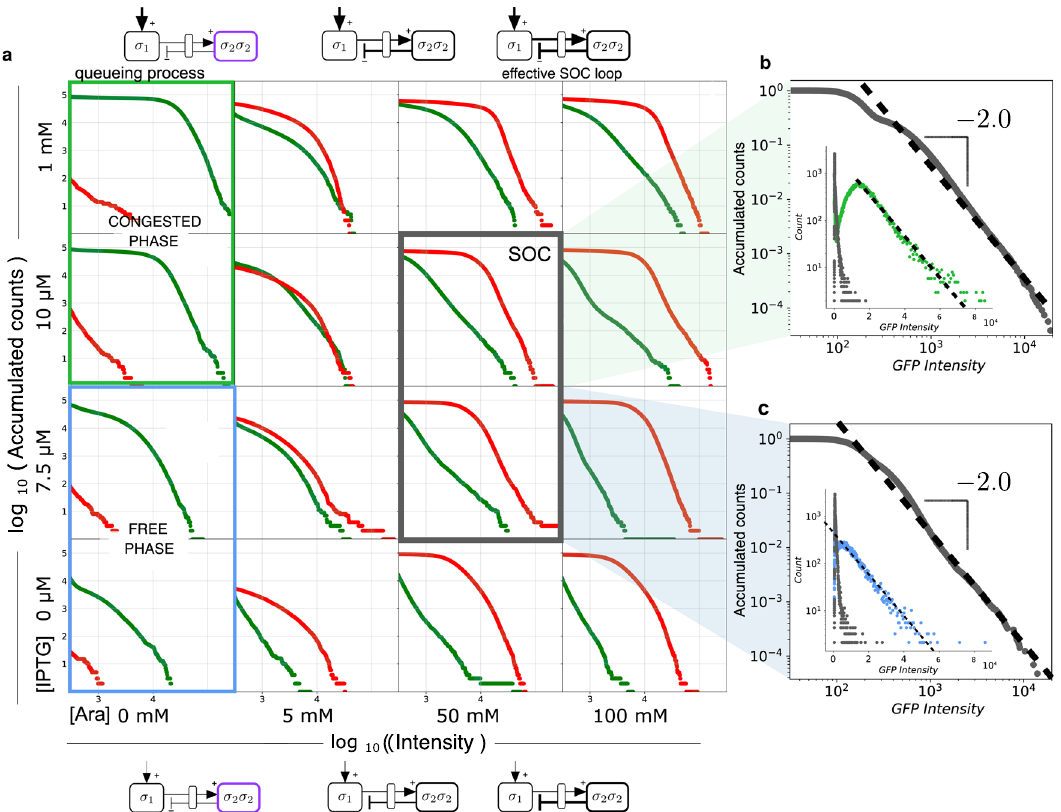
Fig. 4 Statistics and power-law distributions for SOC from the experiments. a Cumulative (non-normalized) distributions P > ( σ 1,2 ) of GFP and RFP fl uorescence levels, here plotted using green and red lines, respectively, for the same set of conditions shown in Fig. 3d. The candidate combinations leading to the SOC state (grey panels) are characterized by a broad range of GFP expression revealed by the tail associated with large bursts. In ( b ) and ( c ) two cumulative histograms are shown for (10 μ M IPTG, 50 mM arabinose (Ara)) and (7.5 μ M IPTG, 50 mM Ara), respectively. Both distributions are close ð σ Þ (cid:2) σ (cid:3) 2 to a scaling law P thus leading to a scaling exponent γ ~ 3, consistent with the stochastic simulations. The insets display the comparison of the 1 1 > raw histograms of the congested state (green dots ( b )) and free-phase (blue dots,( c )), respectively and the SOC state (grey dots) corresponding to the same IPTG conditions. Notice that, unlike the larger images, the x -axes of the insets are linear (so that exponential laws appear as straight lines). Cumulative distributions are shown for fl uorescence levels above 10 2.5 (Q2, Q3, Q4 from Fig. 3). All cumulative distributions have obtained from a constant population size of 10 5 cells. Additional distributions with more detailed IPTG-Ara combinations are shown in Section III.D in the SM and source data are provided as a Source Data fi